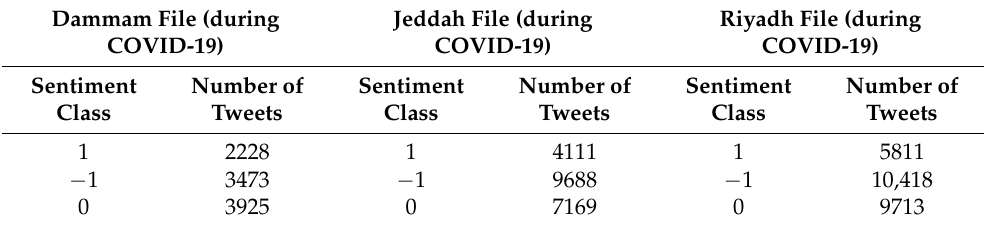
Table 11. Distribution of sentiment classes of (during COVID-19) dataset.